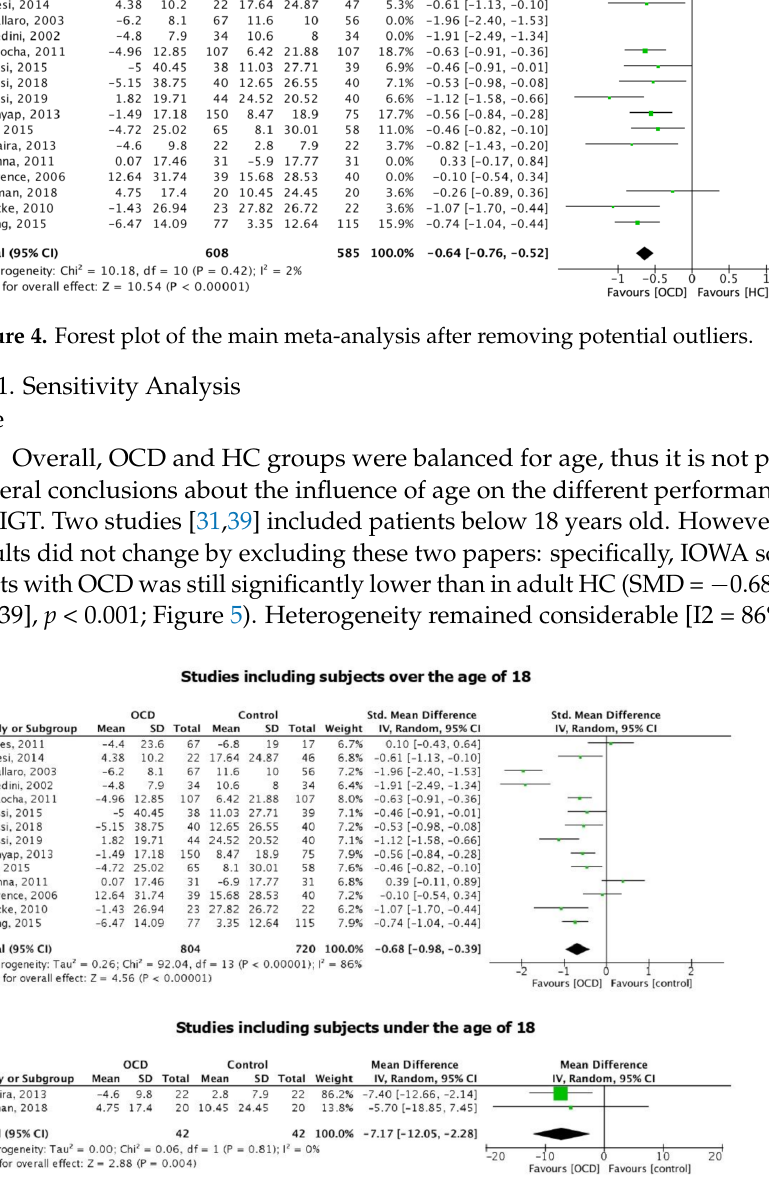
Figure 5. Forest plots of the studies including subjects over the age of 18 and the studies including subjects under the age of